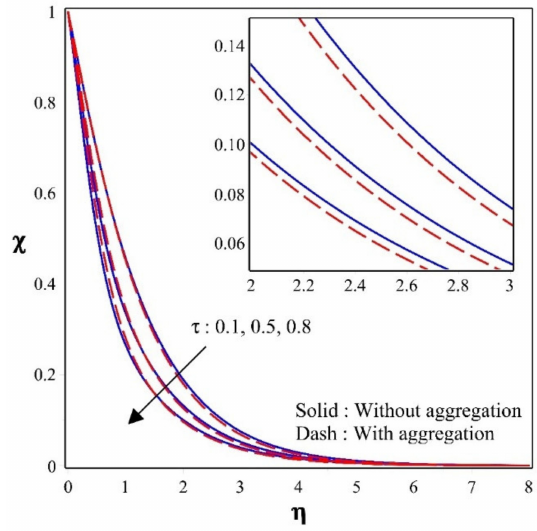
Figure 5. Sway of χ for different values of τ .